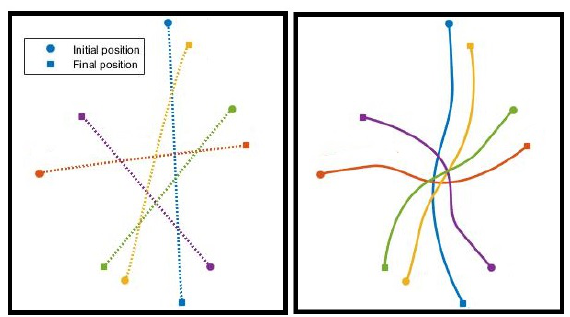
Figure 7. Comparing collision-free trajectories generated with the centralized solution ( left ) and the proposed decentralized approach ( right ) for five drones flying from their initial positions to given final positions. While the central solution yields a shorter flight time, its computation time is significantly longer than average time required to solve the sub-problems in the distributed method.